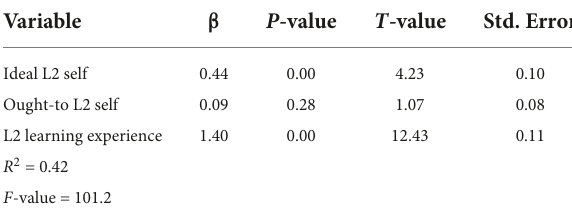
TABLE 4 Descriptive statistics for L2 motivational self-system subcomponents.